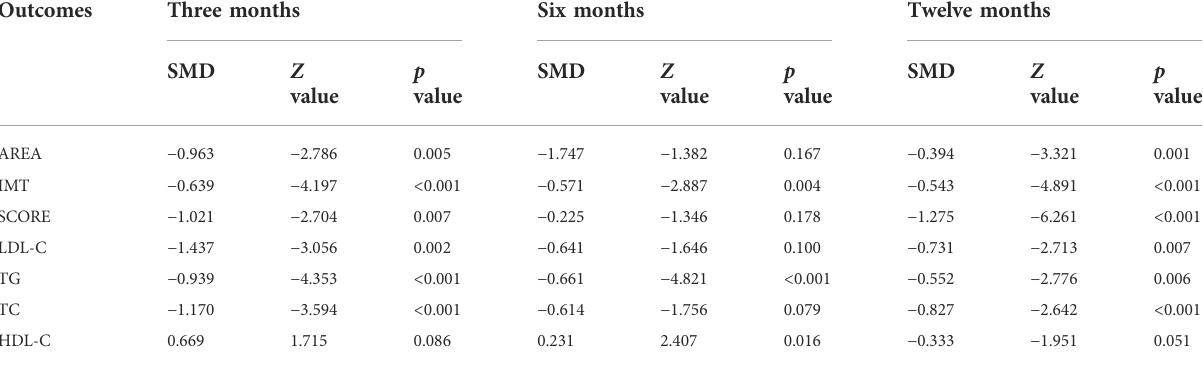
TABLE 5 Subgroup analysis strati fi ed by treatment time.